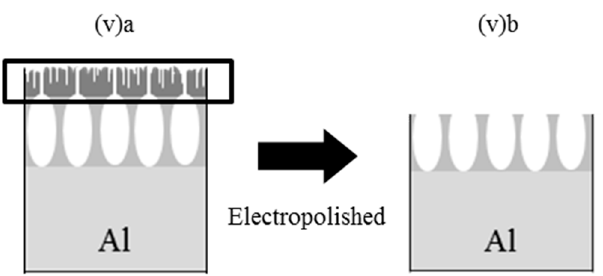
Figure 3. A schematic diagram of the APA preparation under conditions (v): ( a ) as-grown surface and ( b ) the sample obtained after removing the surface oxide layer via electropolishing.